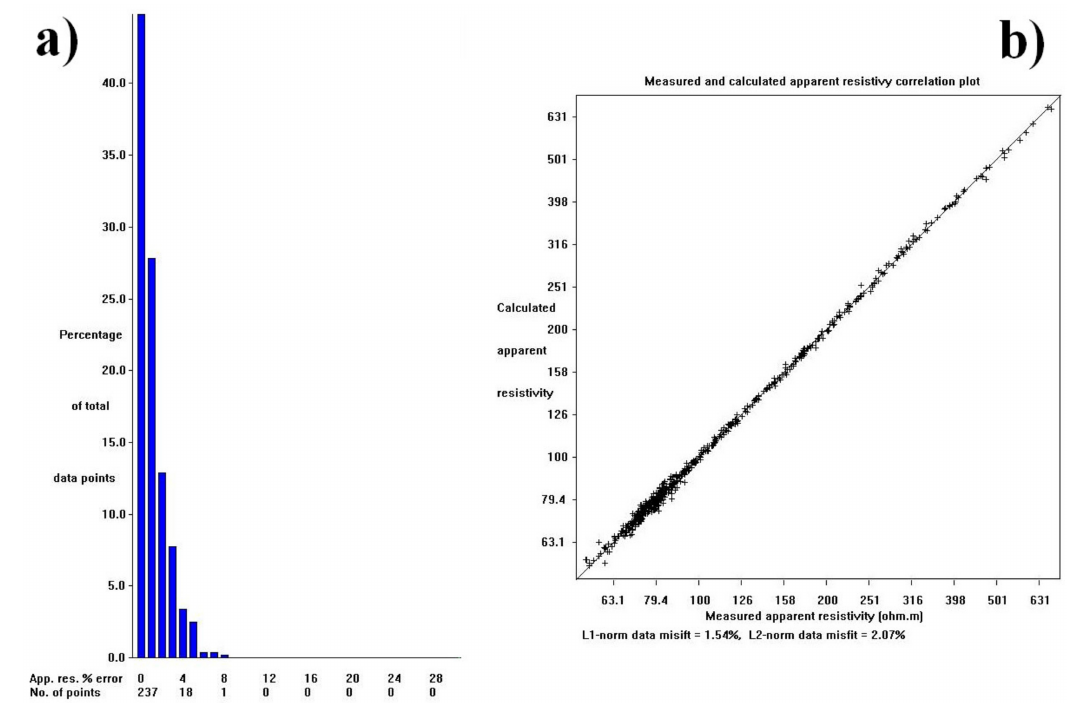
Figure 16. ( a ) Error histogram for Wenner-Schlumberger array; and ( b ) the correlation plot of the relative resistivity measured and obtained on the basis of inversion carried out with Res2Dinv